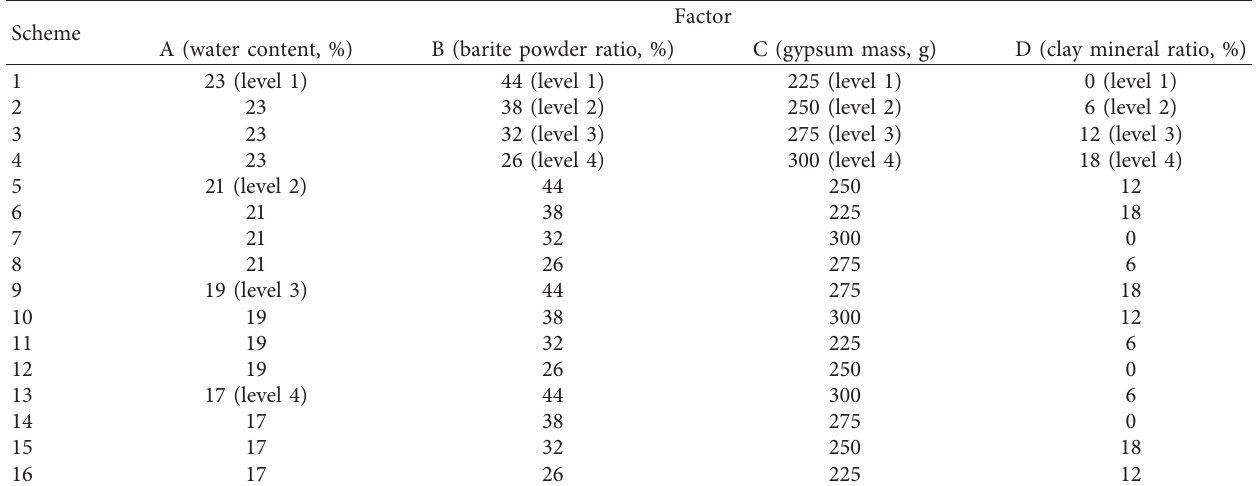
Figure 2: Particle size distributions of different raw materials: (a) clay minerals and barite powder; (b) gypsum powder. Table 4: Experimental